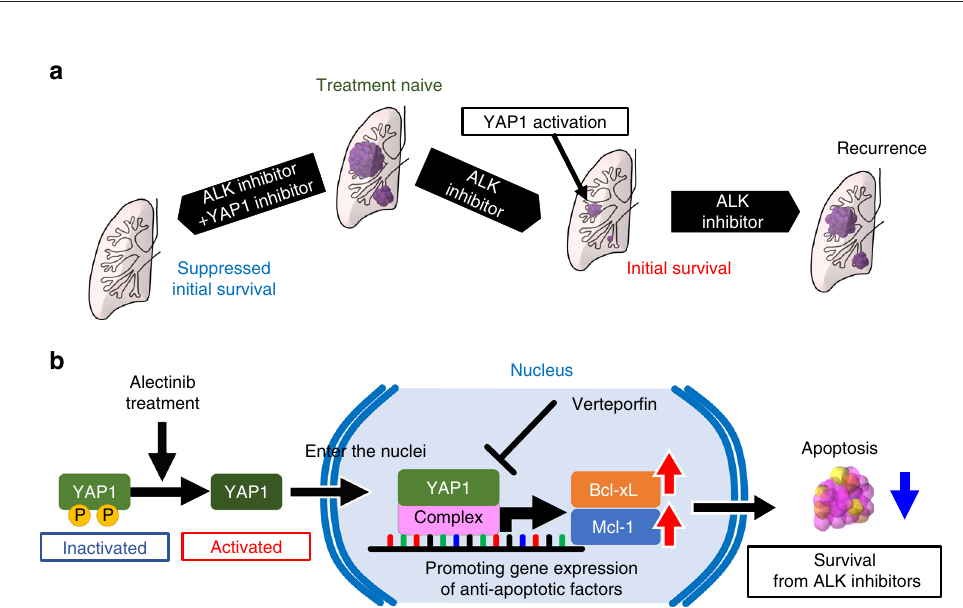
Fig. 8 Graphical summary of the present study. a YAP1 was activated when ALK-rearranged cancer cells survived a treatment with ALC. Combinatorial therapy against ALK and YAP1 may achieve complete remission in treatment naïve ALK-rearranged tumors. b A mechanism underlying initial survival against ALC. YAP1 is activated by ALC. Activated YAP1 enters the nucleus and promotes the expression of BCLXL and MCL1 . MCL1 and Bcl-xL inhibit apoptosis. Vertepor fi n inhibits the promoter activity of YAP1, as reported